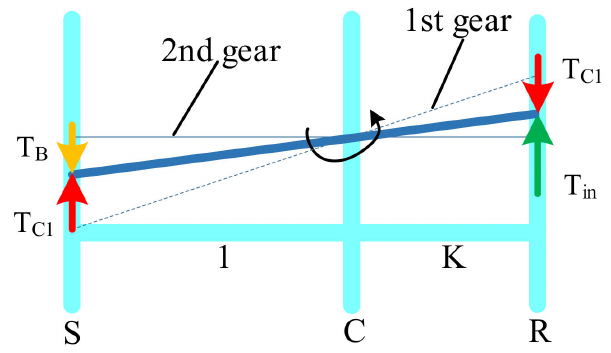
Figure 3. The lever diagram of the downshift